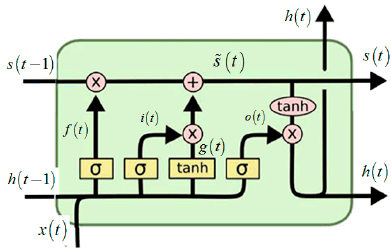
Figure 6. A cell of a long short-term memory neural network (LSTM NN).